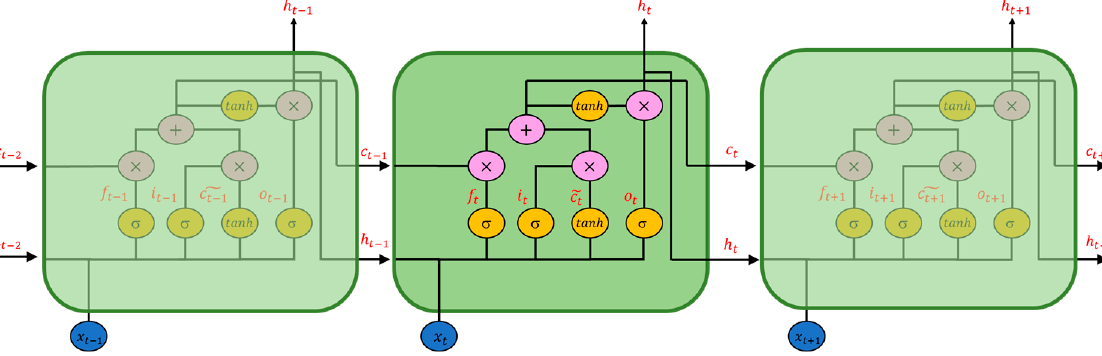
Figure 5. Structure diagram of LSTM.